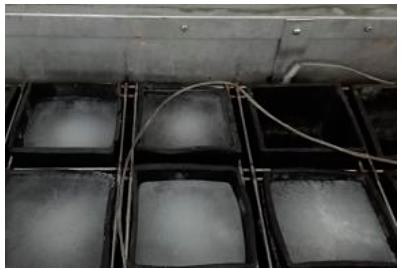
Figure 4. Specimens placed in the rubber sleeves.